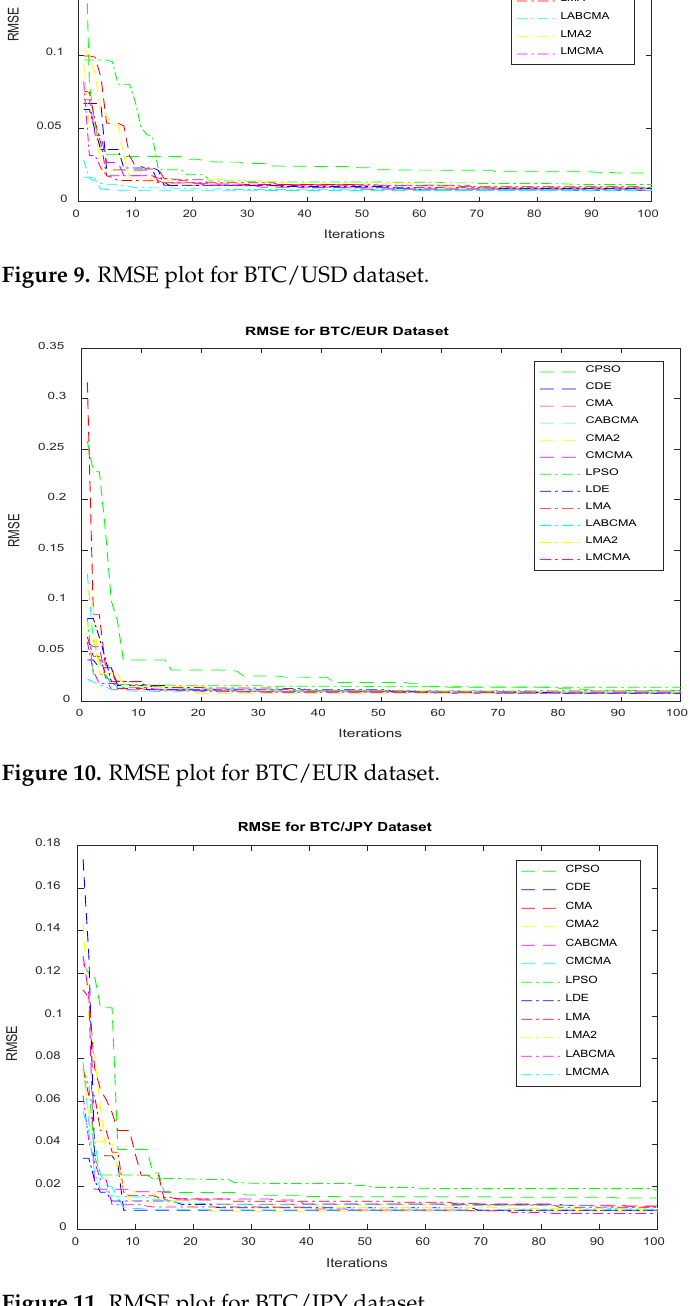
Figure 11. RMSE plot for BTC/JPY dataset.